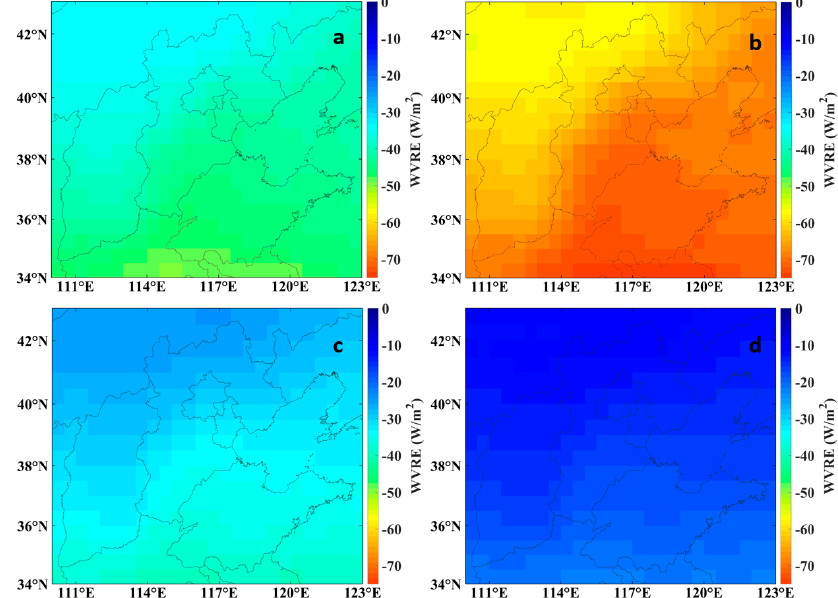
Figure 8. Spatial distribution of seasonal mean WVRE in northern China from 2001 to 2015: ( a ) Spring, ( b ) Summer, ( c ) Autumn, and ( d ) Winter.